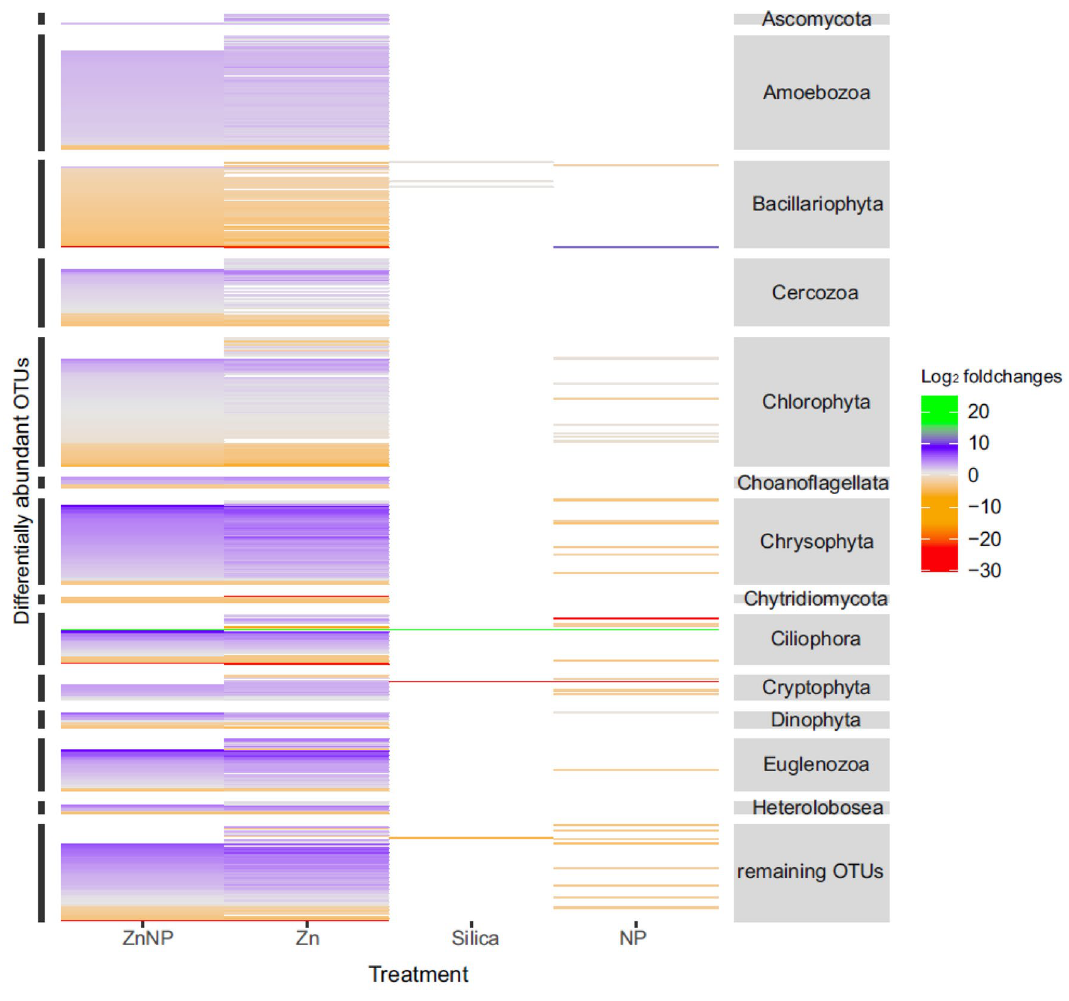
Figure 4. Log 2 -fold changes of differentially abundant OTUs and their affiliation to subgroups compared to the control. Only differences with an adjusted p value of 0.01 are shown. Each line represents one OTU. OTUs are sorted in descending order based on their log 2 -fold changes in the ZnNP treatment. Log 2 fold changes are color-coded, the descending order is: green, blue, grey, orange, red. Differences visible here are solely based on the factor